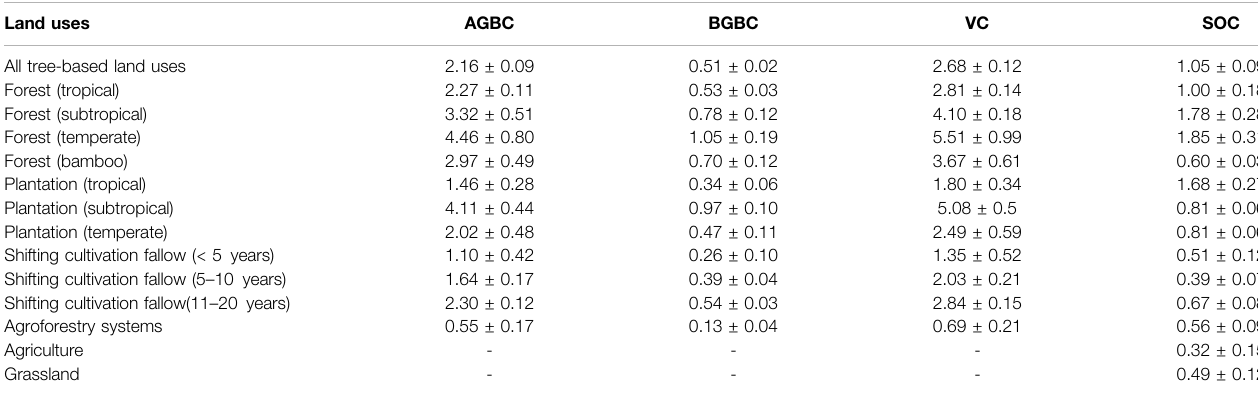
Land uses AGBC BGBC VC SOC All tree-based land